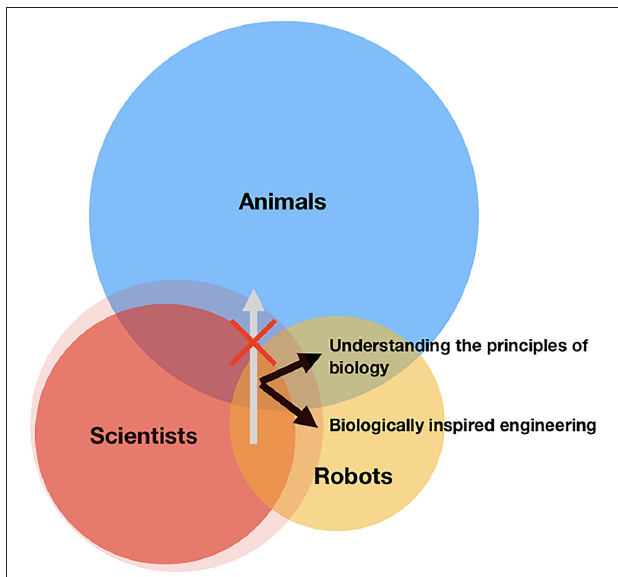
FIGURE 1 | Human, animal, and robot worlds. Fruitful avenues and fallacious ones, in the use of machines as living organisms. The red region stands for the limit of scientists’ knowledge, the blue region the world of animal behavior, and the yellow region the scope of robotics. The intersection between red and blue represents the current understanding of animal behavior; between red and yellow is the progress in robotics; between blue and yellow means the similarities between animal and machine. The intersection at the center is the mechanistic understanding of animal behavior that can be justifiably applied to robotics and vice versa (e.g., biocybernetics). The black arrows indicate how the intersection at the center can direct the development of robotics and understanding animal behavior, and the gray one identifies an erroneous application of robotics to studying